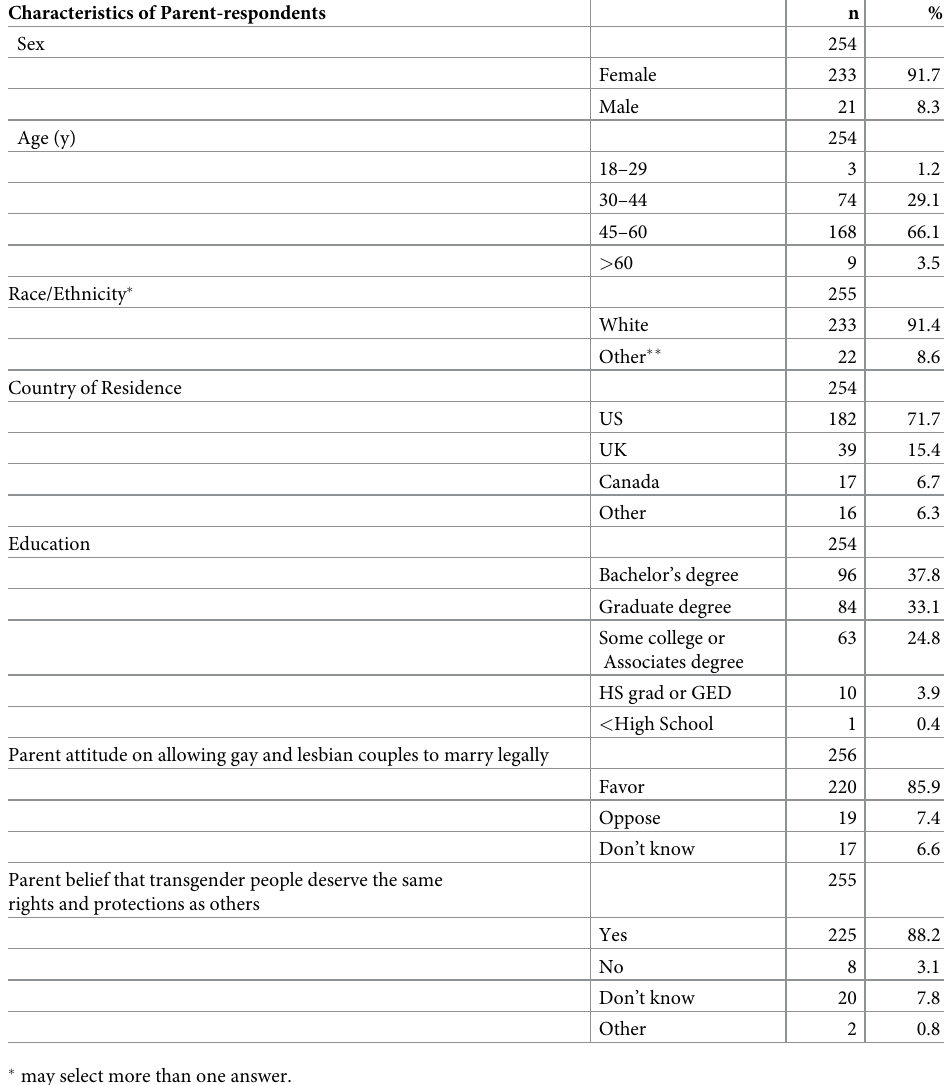
Table 1. Demographic and other baseline characteristics of parent